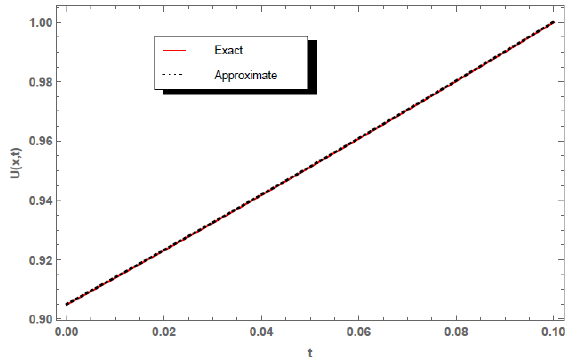
Fig. 3: Behavior of second term approximate solution U ( x , t ) w.r.t. x and t, when α = 0.3 for Eqs. (7)–(8).